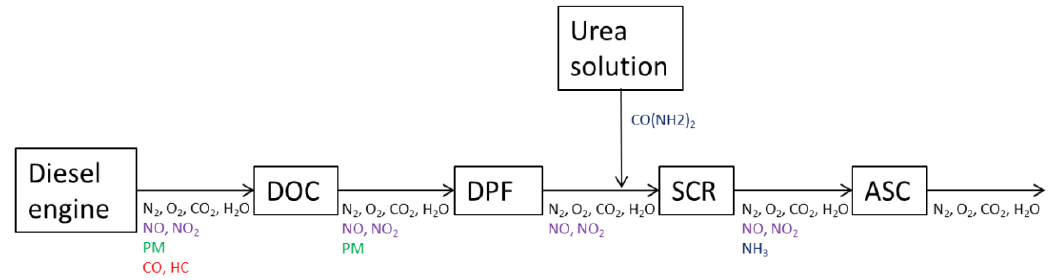
Figure 1. Schematic view of a typical heavy-duty vehicle aftertreatment system. The catalyst investigated in this study was taken from an aftertreatment system with this configuration. DOC: diesel oxidation catalyst; DPF: diesel particulate filter; SCR: selective catalytic reduction catalyst; ASC: ammonia slip catalyst.